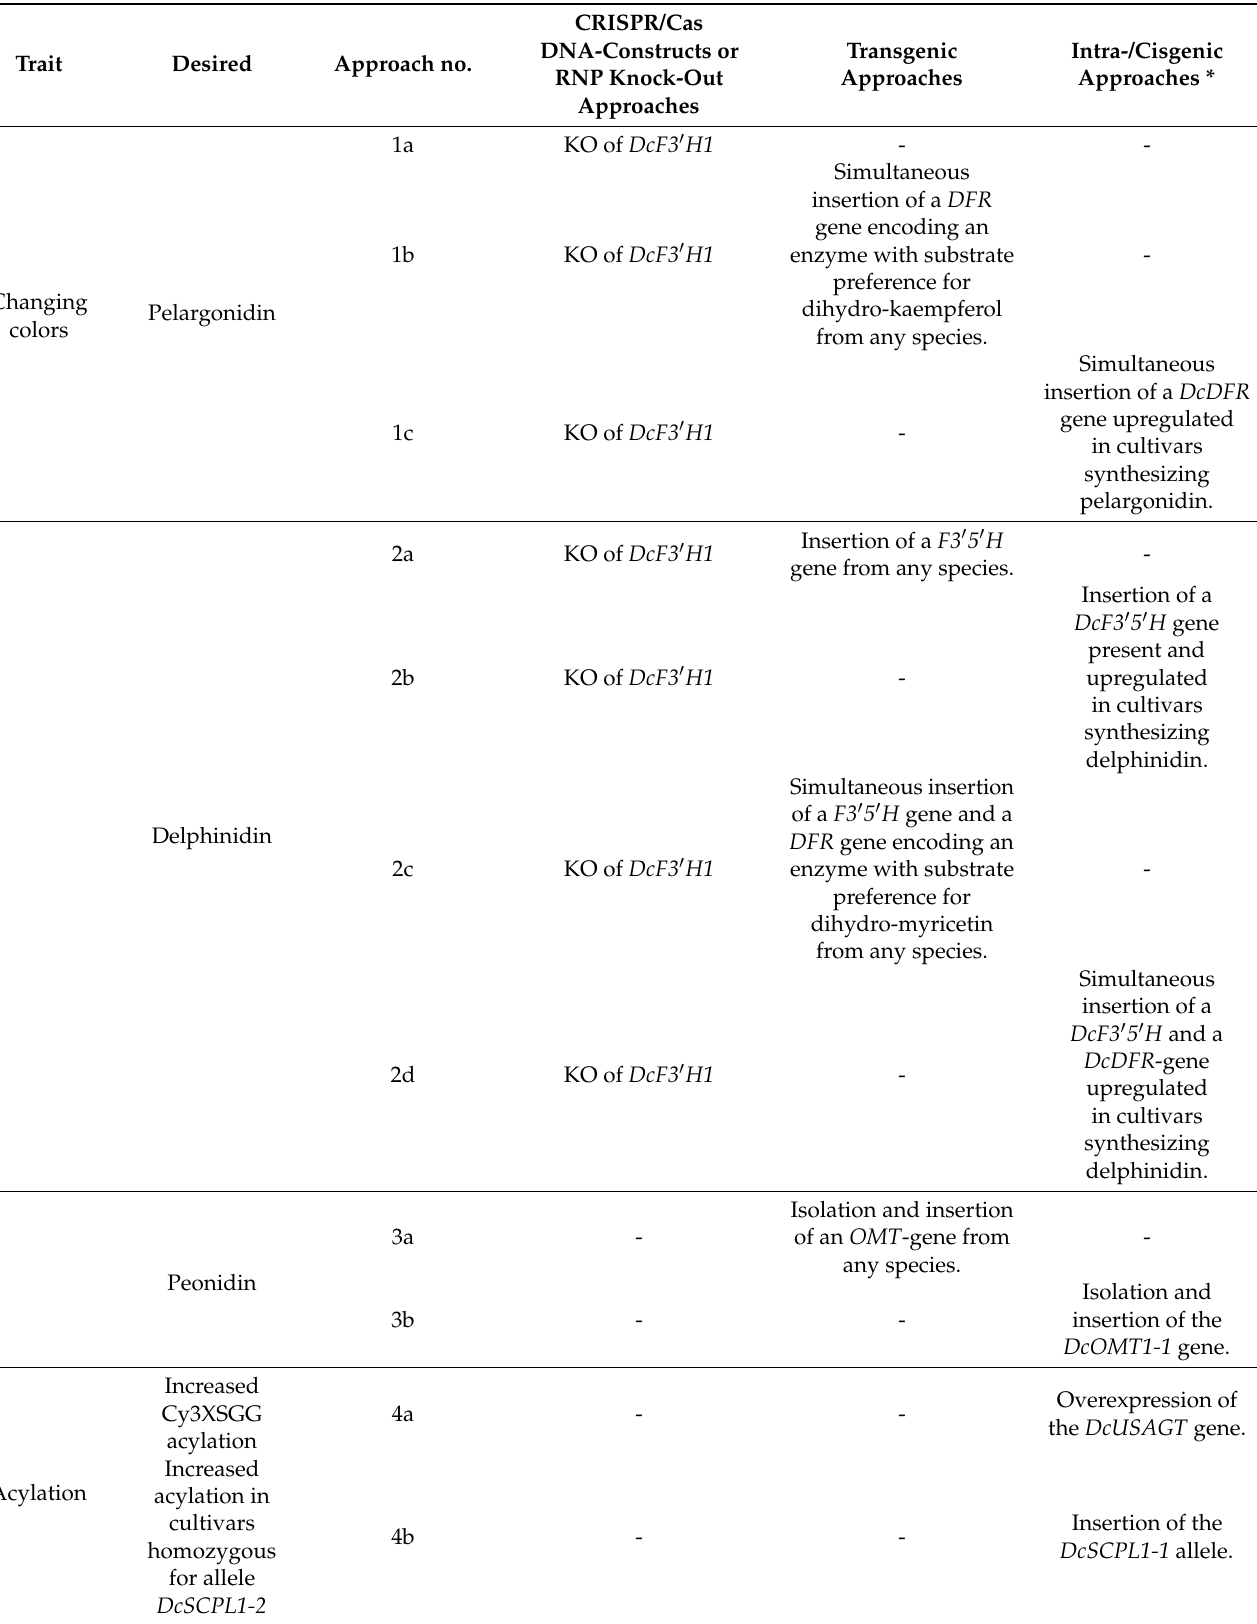
Table 1. Potential approaches to modulate the anthocyanin composition in black carrots. Trait Approach no.